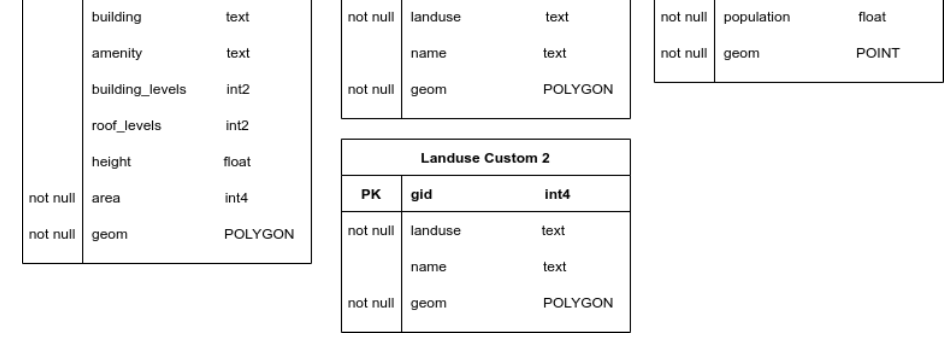
Figure 6. Optional input tables.